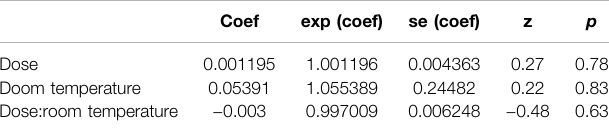
TABLE 3| Fixedcoef fi cientsoftheeffects ofpupaechillingonmale Ae.albopictus